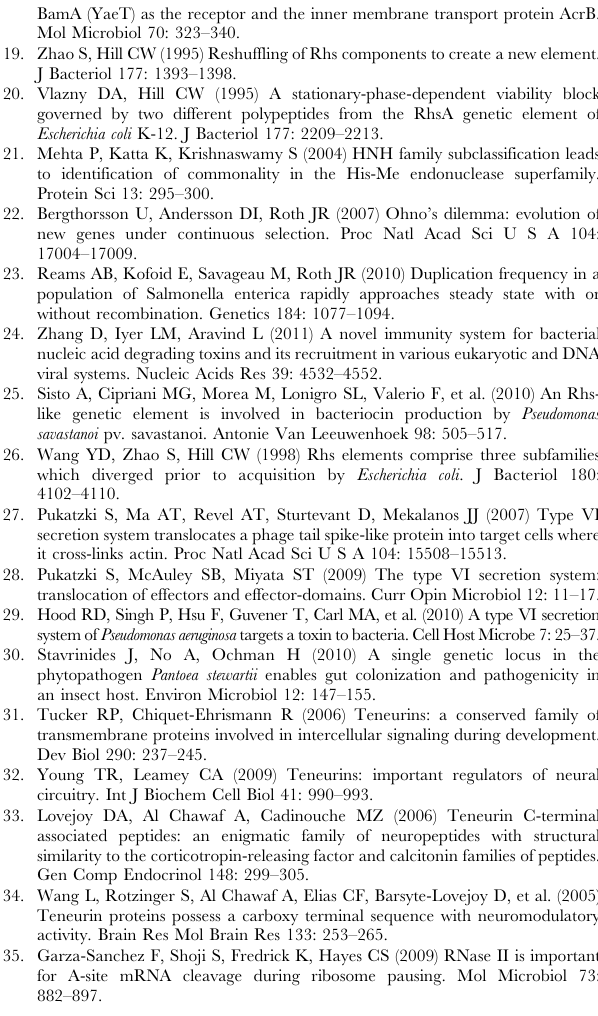
Figure S8 The C-terminal regions of Rhs proteins are variable. Pairwise alignment of related Rhs proteins from Y. pseudotuberculosis IP31758 and Y. pseudotuberculosis IP32953. Regions of identity are shaded gray. Sequences diverge abruptly after the DPxGL motif (boxed). (TIF) Table S1 Homologies between selected CdiA-CT and Rhs-CT sequences. Rhs-CT sequences were identified by BLAST searches using selected CdiA-CTs as the query sequences. The presence of probable rhs-CT/rhsI orphan modules is indicated for each Rhs system. Table S2 Sequence identifiers for CdiA and Rhs proteins. The UniProt, GenBank and locus tag accession numbers are presented for each CdiA and Rhs protein discussed in the